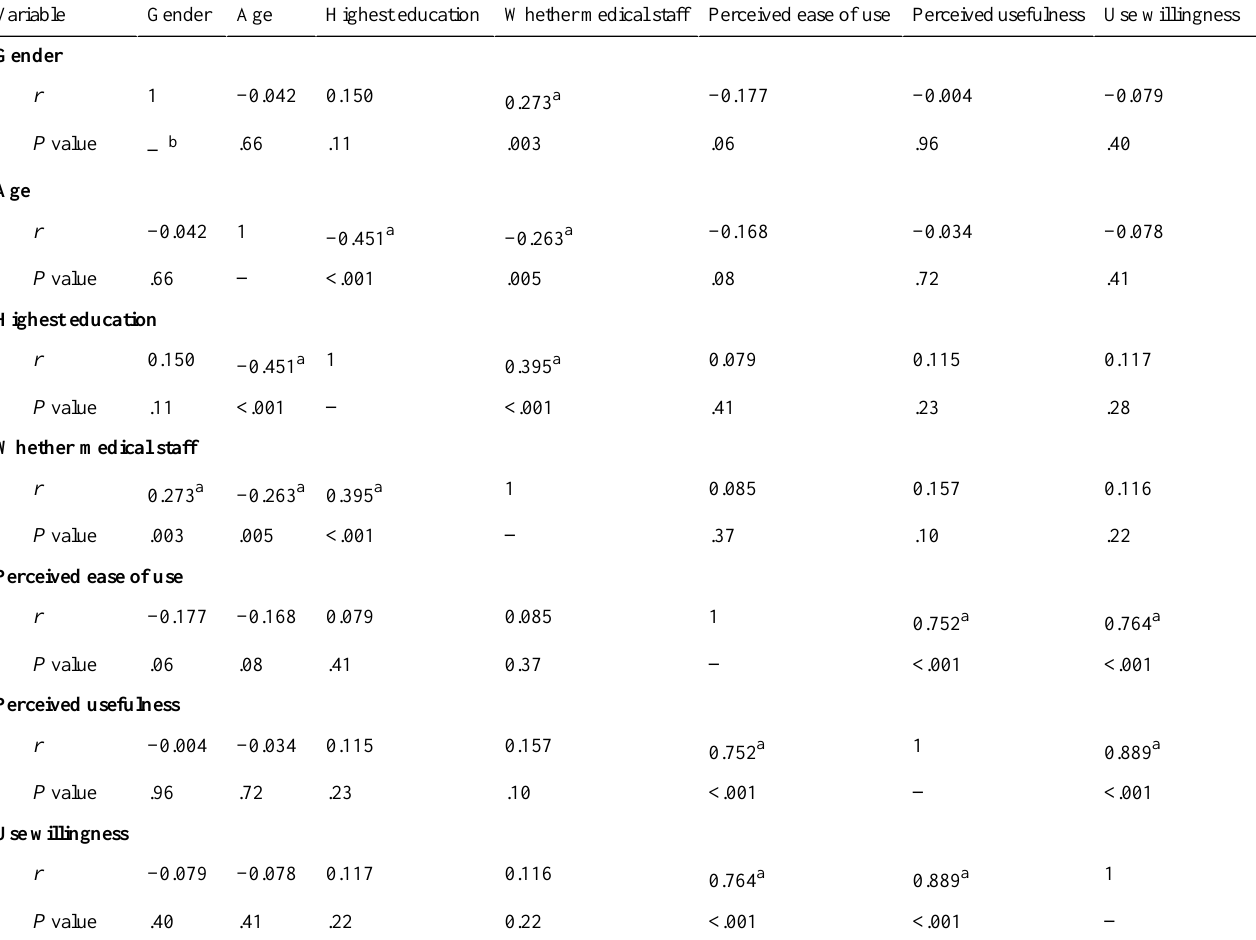
Table 3. Correlation analysis (Pearson r and two-tailed P ) among the research variables.